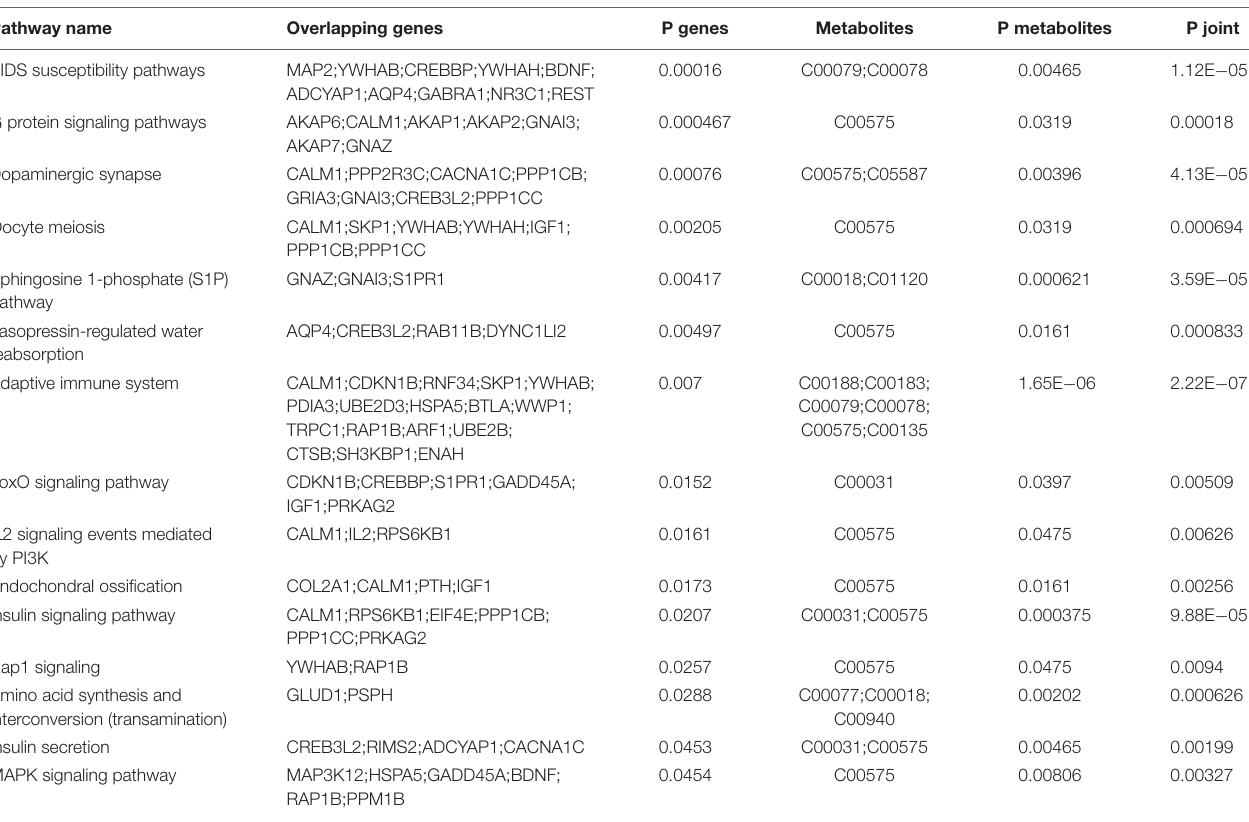
TABLE 4 | Correlated analysis between microRNAome and metabolic profiles using IMPaLA web